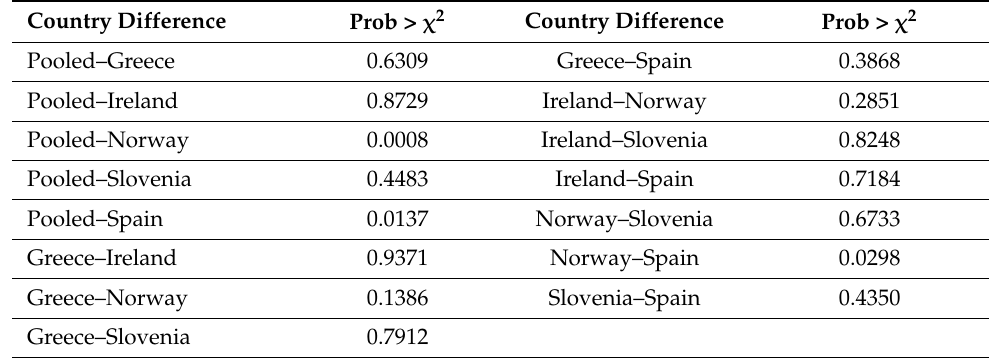
Table 5. Wald test results for the pooled and national subsample models (households).